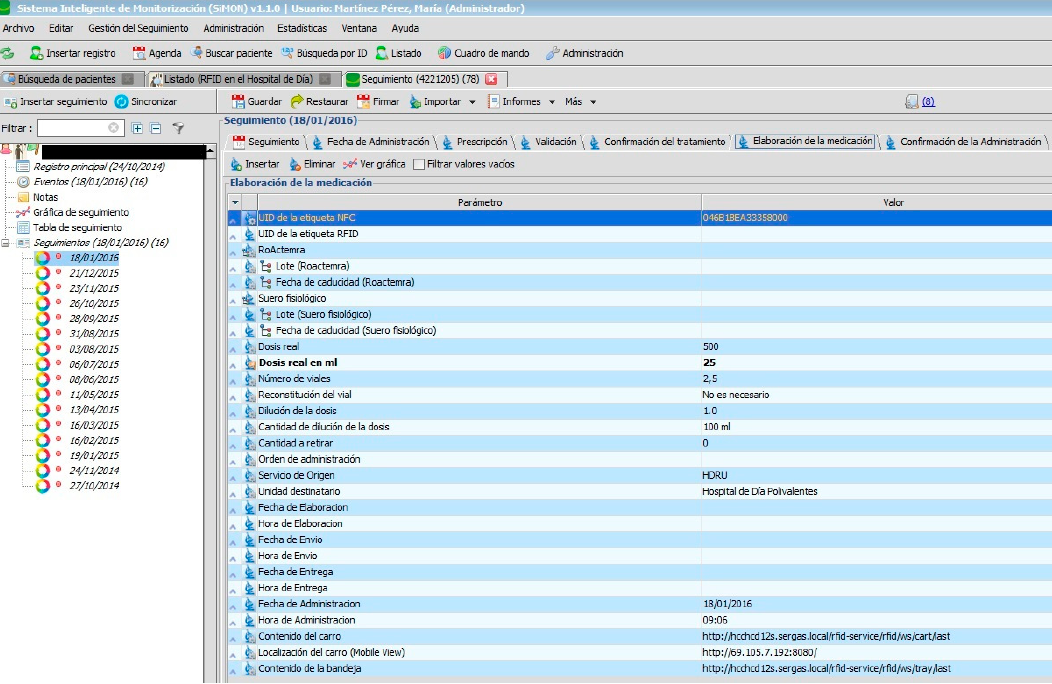
Figure 8. Elaboration of medication.